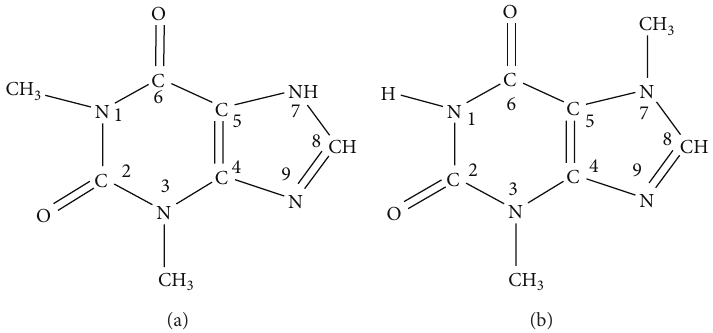
Figure 1: Structure of (a) theophylline and (b) theobromine